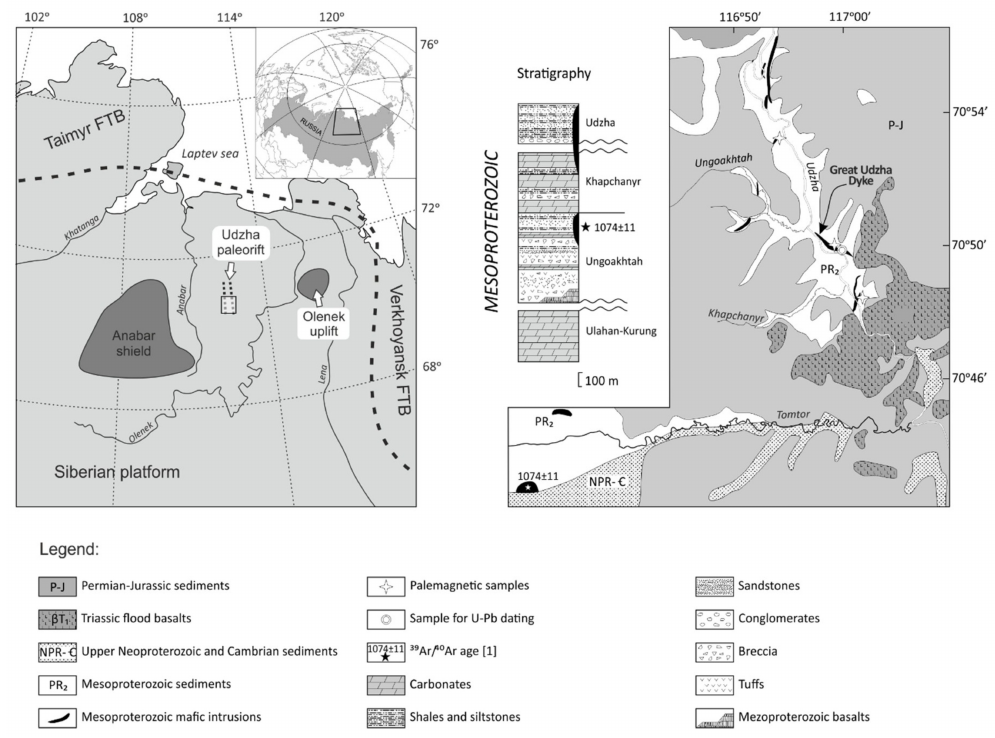
Figure 1. Location of the Udzha paleo-rift in the northern Siberian Craton ( left ), and the distribution of the Mesoproterozoic dykes within the geological framework and the location of studied samples ( right ). The bold dotted curve outlines the boundary of the Siberian